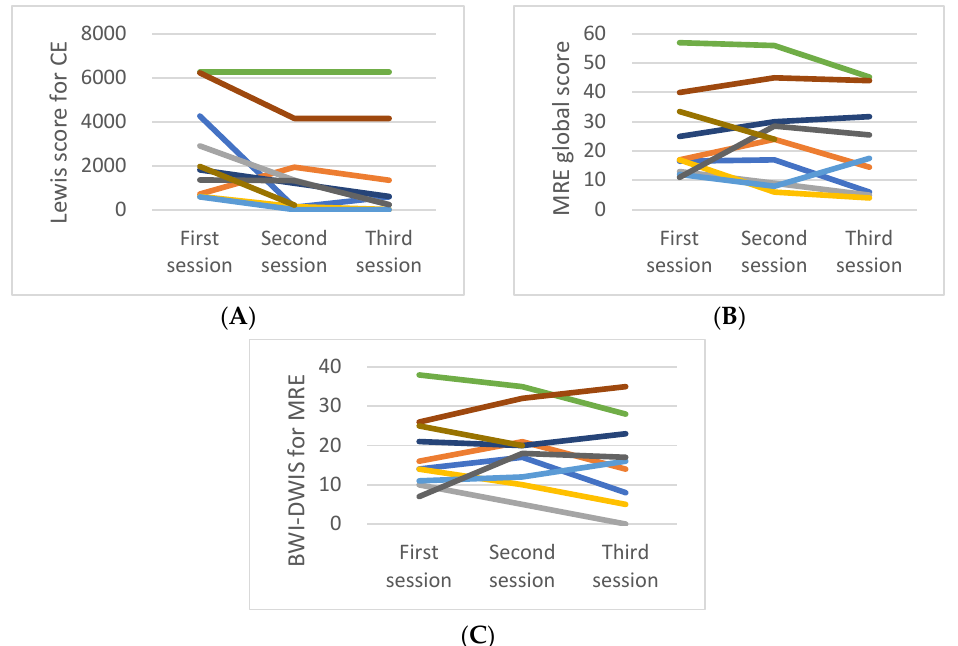
Figure 1. Changes of Lewis score of capsule endoscopy (CE) ( A ), magnetic resonance enterography (MRE) global score ( B ), and bowel wall inflammation severity diffusion-weighted image score (BWI- DWIS) for MRE ( C ) in 11 pediatric Crohn’s disease patients. The same color in each picture represents the same